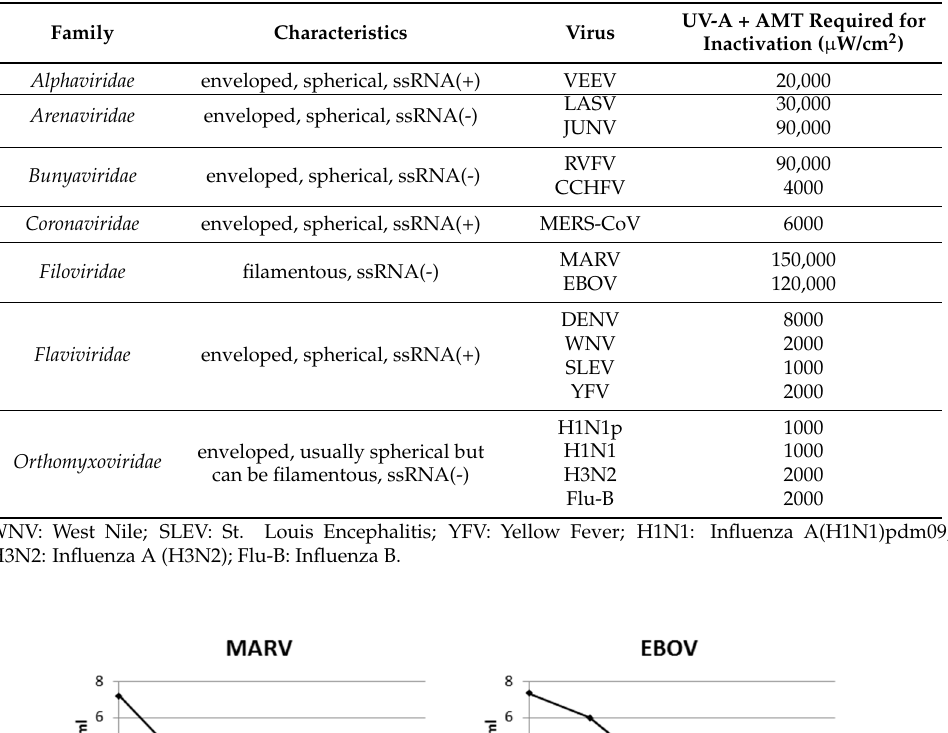
Table 4. Total microwatts UV ‐ A required to inactivate different viruses in the presence of 4 ′‐ aminomethyl ‐ trioxsalen (AMT). Total microwatts UV-A required to inactivate different viruses in the presence of 4 1 -aminomethyl-trioxsalen (AMT).